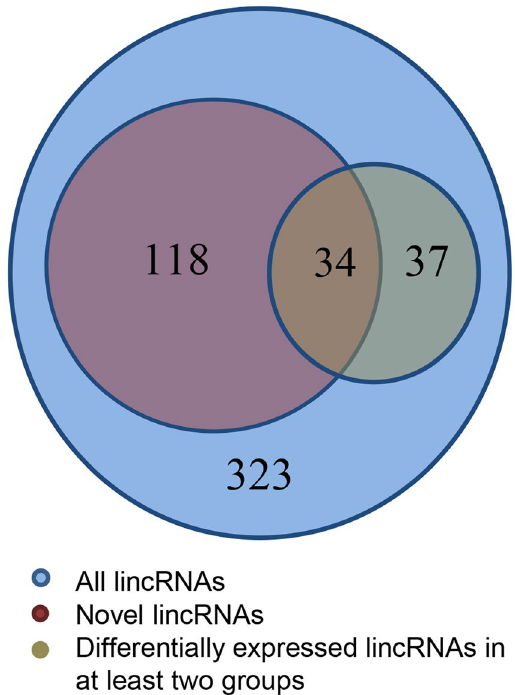
Figure 2. Statistics of different kinds of lincRNAs. The blue circle indicates all lincRNAs identified in this study, the red circle indicates the novel lincRNAs and the brown circle indicates the lincRNAs that differentially expressed in at least two